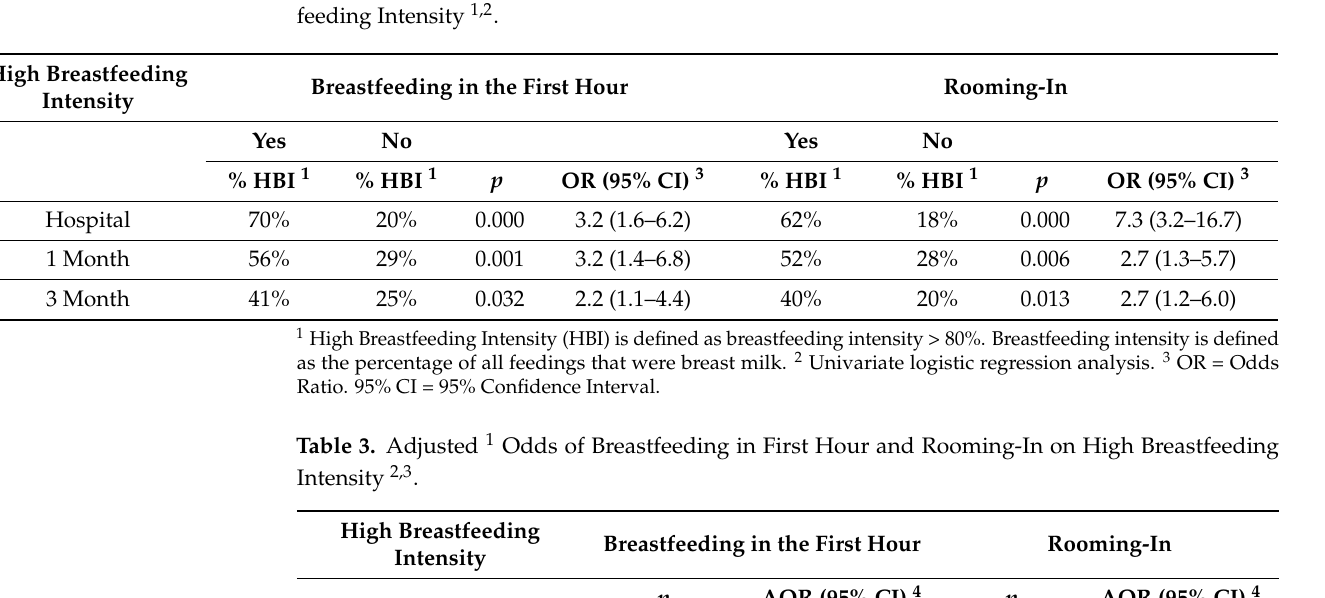
Table 2. Unadjusted Odds Ratio of Breastfeeding in the First Hour and Rooming-In on High Breast- feeding Intensity 1,2 .